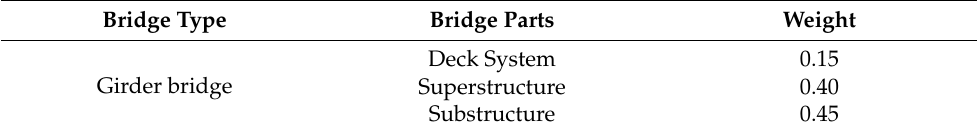
Table 1. Weighting values for bridge ratings in China (CJJ